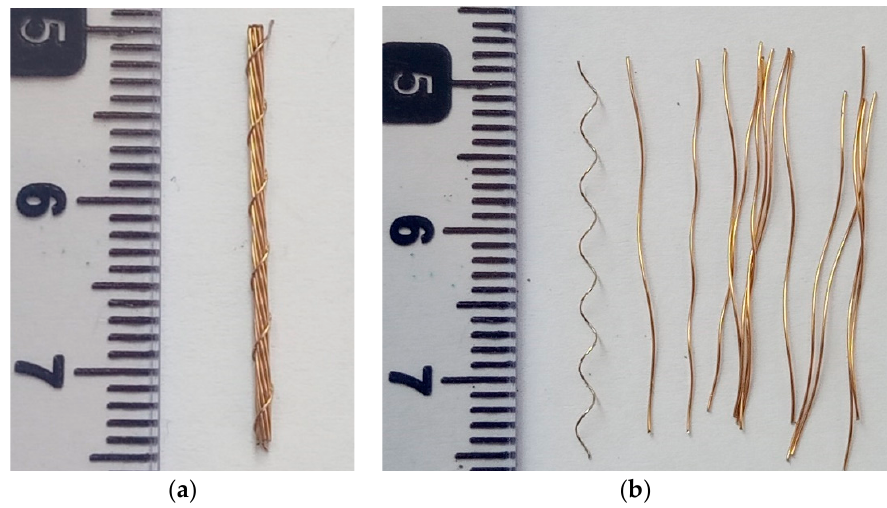
Figure 3. Structure of bundled steel fiber: ( a ) bundled steel fiber, ( b ) unwound steel wires.